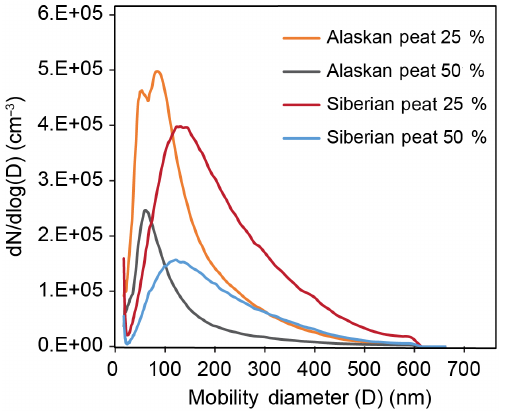
Figure 2. Study-averaged mobility number–size distribution of aerosols from Alaskan and Siberian peat samples.